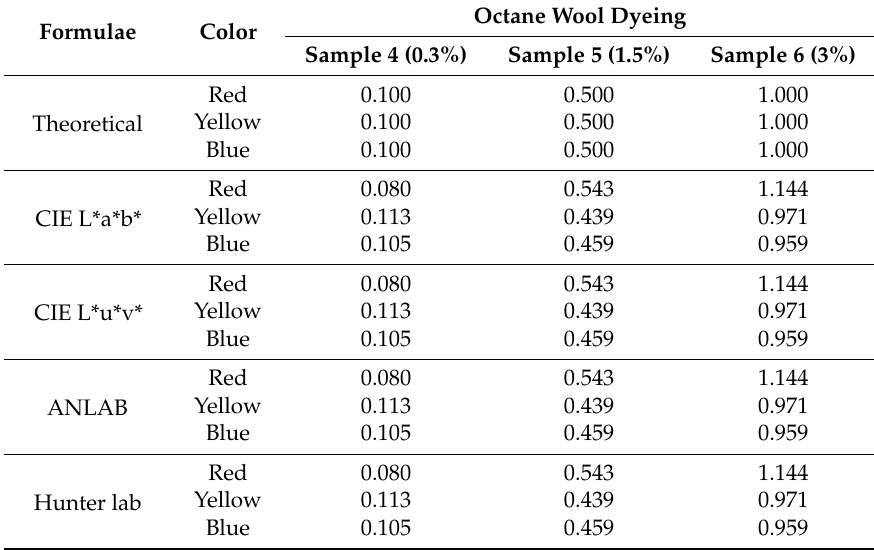
The color-matching recipes of octane-dyed standard wool samples are shown in Table 8. Results were found to be consistent for color-matching predictions of Sample 4 (red: 0.080; yellow: 0.971; blue: 0.959), even though different formulae were used. Table 8. Color-matching recipes of octane-dyed standard wool